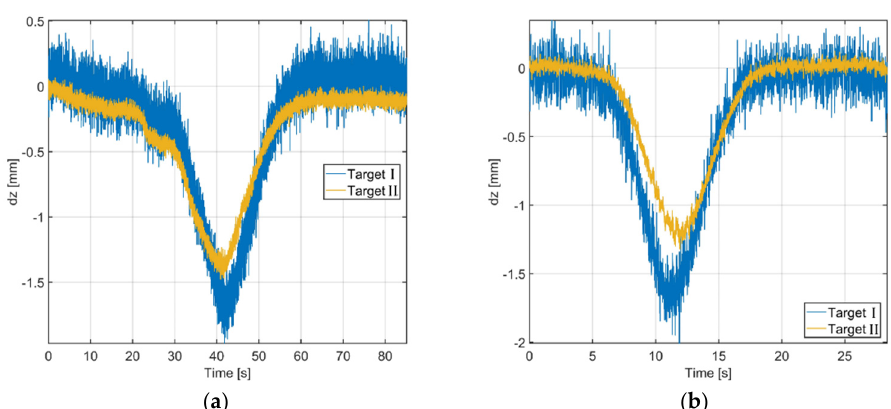
Figure 21. Measured displacement of target I and II (see Figure 20): ( a ) the truck approaches the bridge from the left side; ( b ) the truck approaches the bridge from the right side.